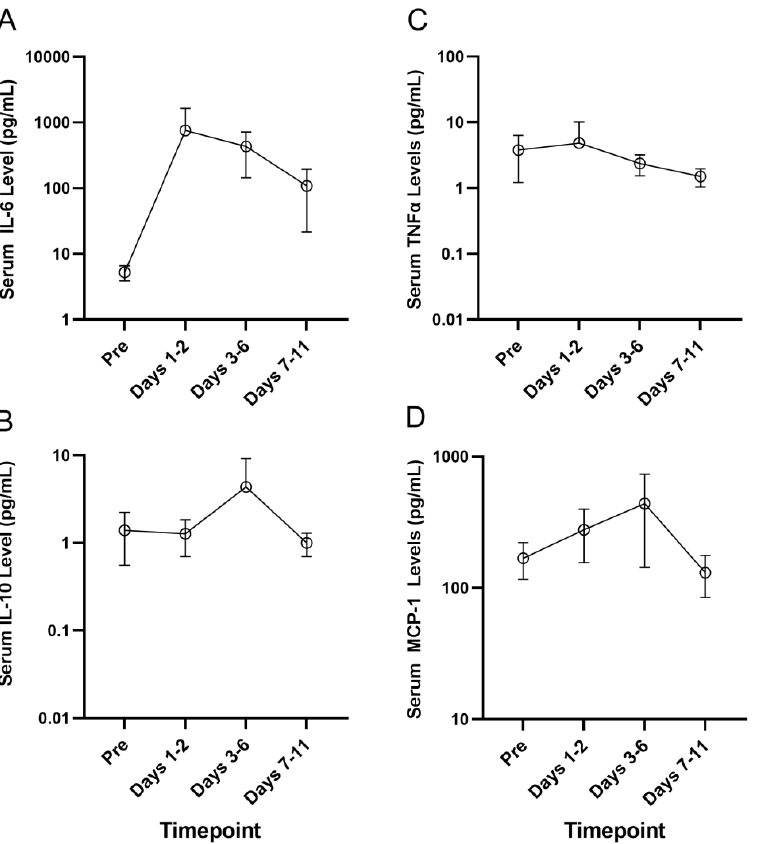
Figure 1. Serum cytokine levels of patients who developed CRS after APVO436. The MSD U-PLEX assay platform was used for measurement of serum levels of the proinflammatory cytokines IL-5, IL-6, IL-10 and TNF- α by electrochemiluminescence in serum samples from a select group of 4 primary AML patients who experienced Grade 2–4 CRS. Serum samples obtained pretreatment and at multiple timepoints after initiation of APVO436 treatment were used to understand the longitudinal changes in serum cytokine levels. The results are also presented in Table S6. See text for detailed discussion of the results. ( A ) Serum IL-6 levels ( B ) Serum IL-10 levels ( C ) Serum TNF α levels ( D ) Serum MCP-1